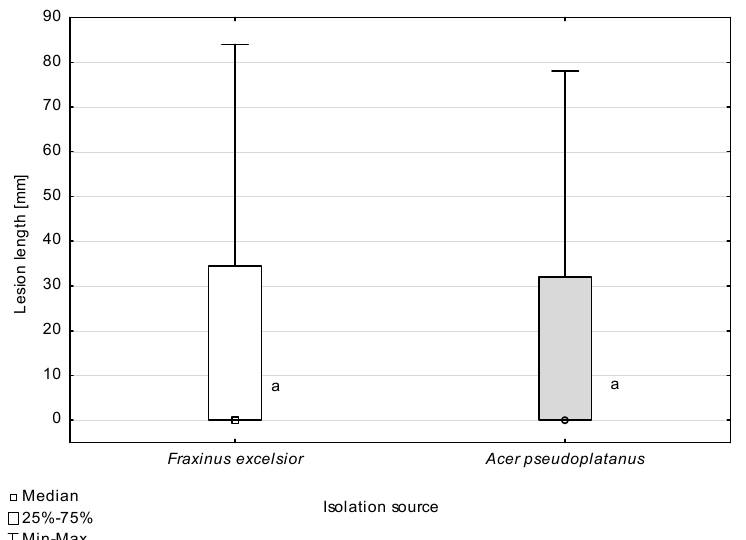
Figure 10. Lengths of necrotic lesions on petioles inoculated with Apiognomonia hystrix in regard to isolates’ host origin, eight weeks post inoculation. Values indicated with the same letters have been determined significantly not different at α = 0.05 in Mann–Whitney U test.